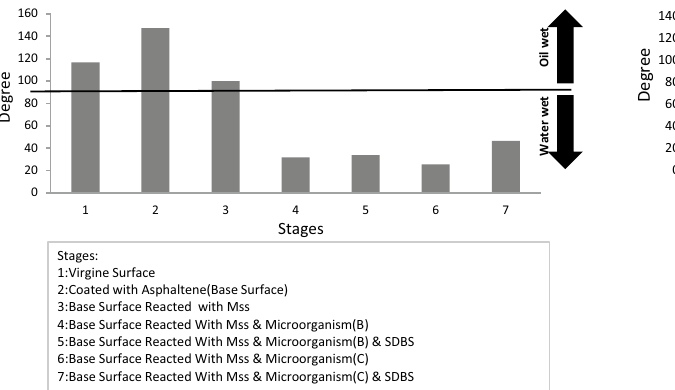
Fig. 14 Contact angle measurement for Kuh-e-Mond asphaltene sam-